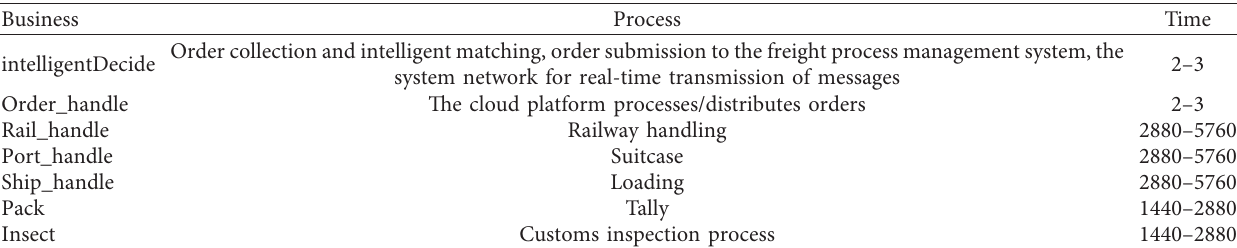
Table 7: Time consumption (min) of main business links of the process after